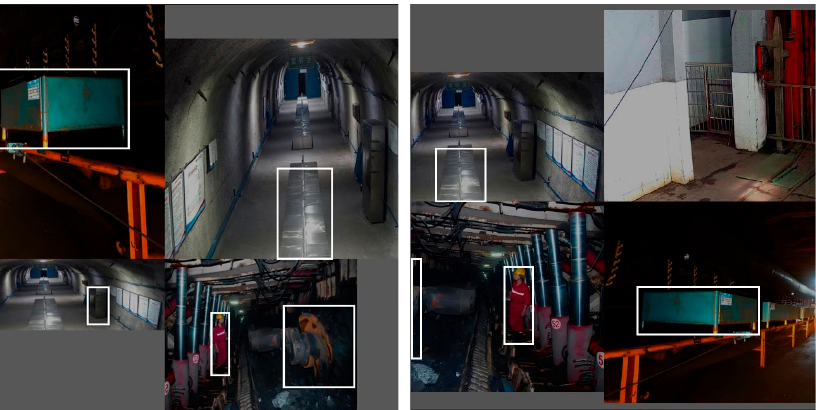
Figure 5. Mosaic data enhancement effect.